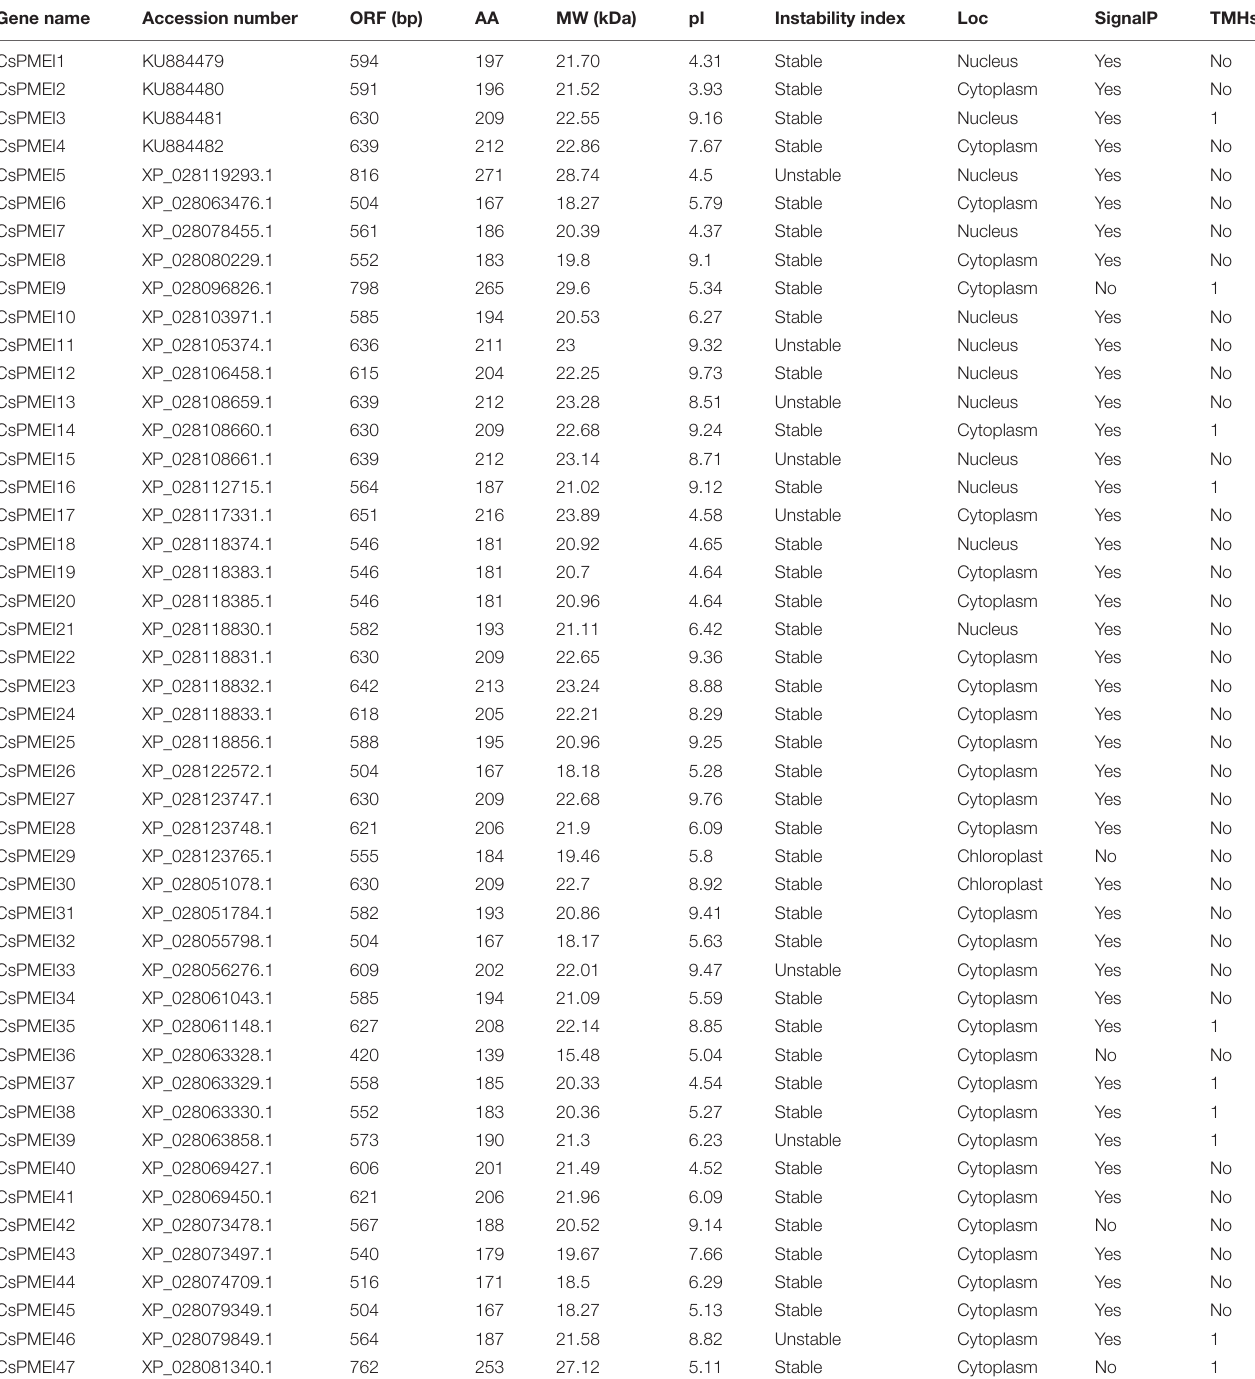
TABLE 1 | Basic information of CsPMEIs